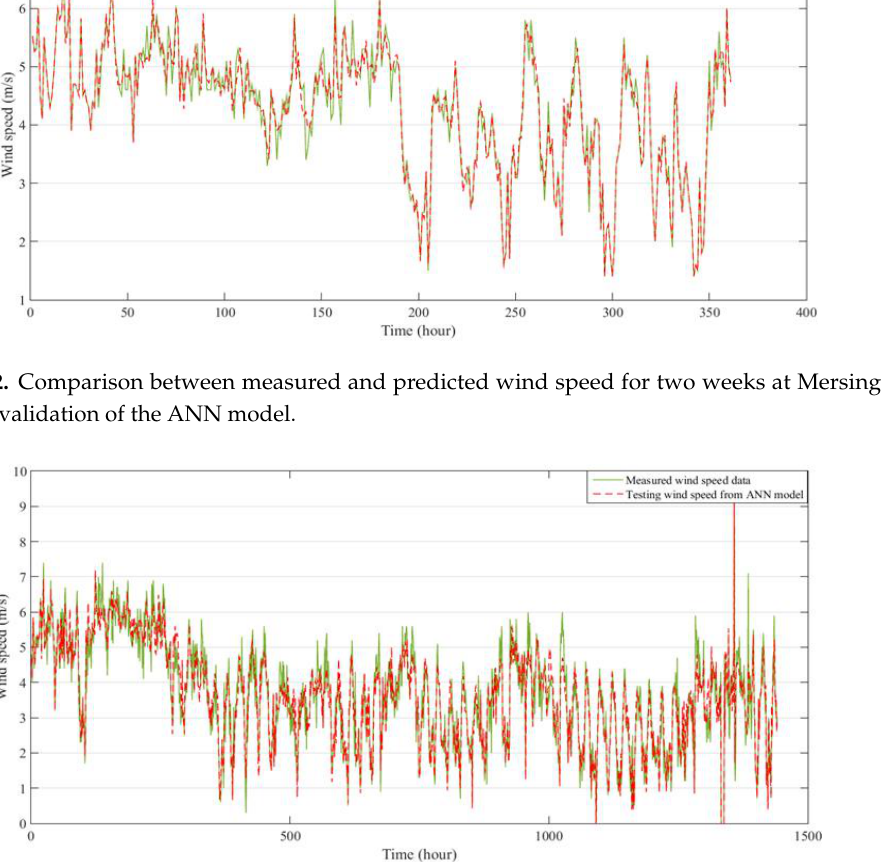
Figure 13. Comparison between measured and predicted wind speed for two months at Mersing in 2015, for validation of the ANN model.